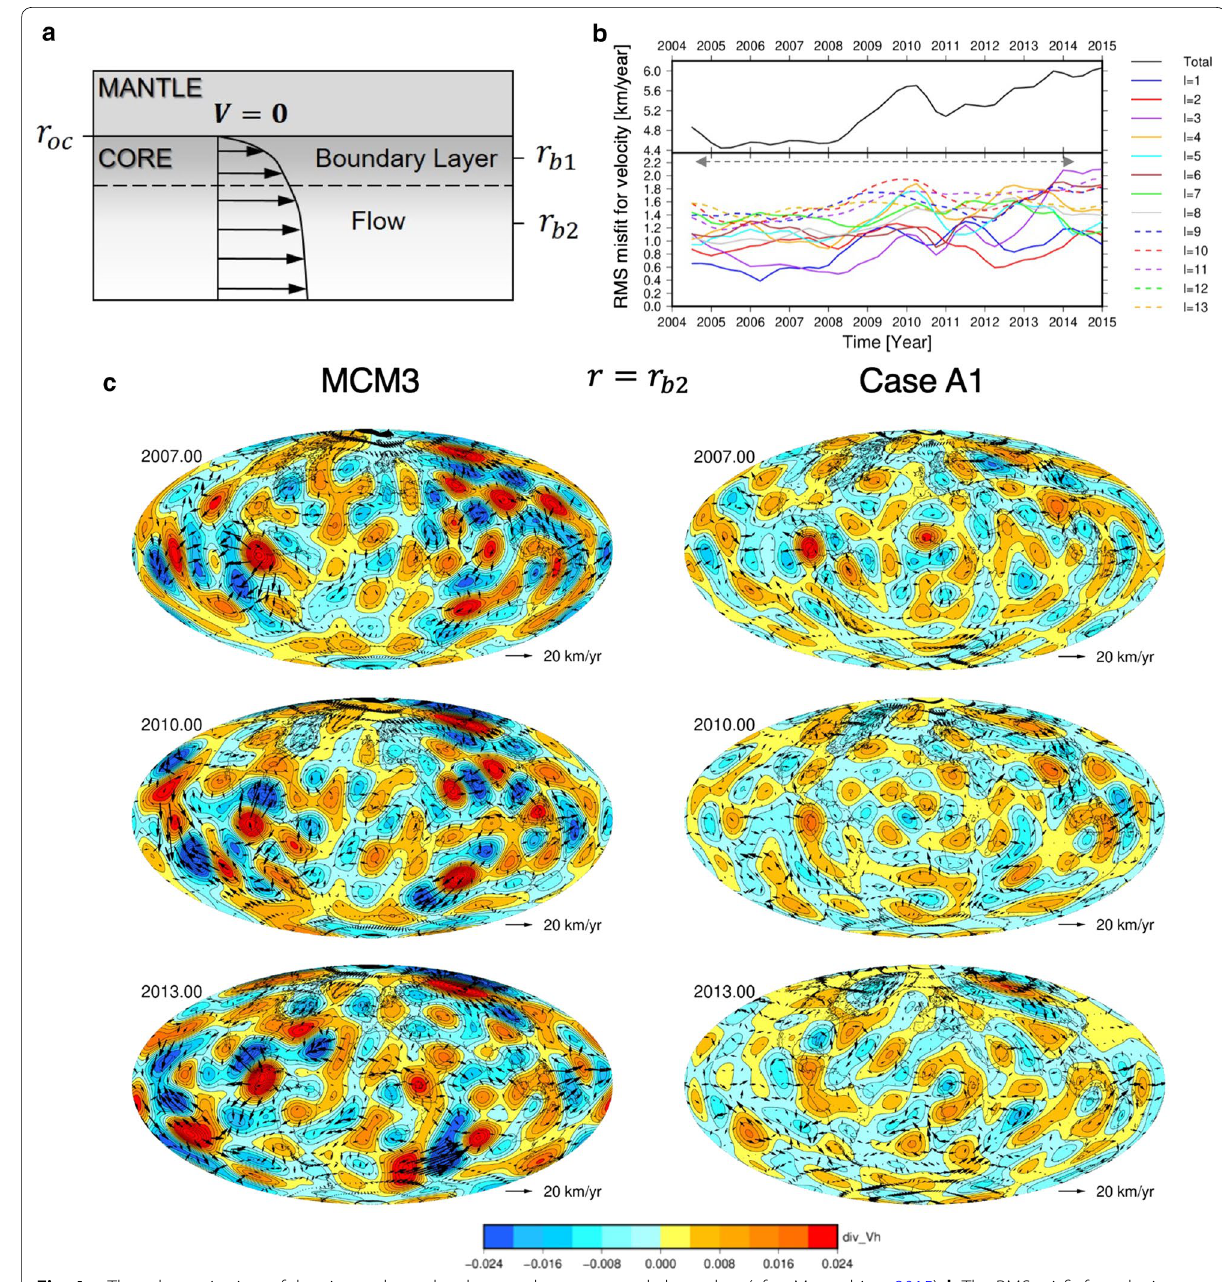
Fig. 4 a The schematic view of the viscous boundary layer at the core–mantle boundary (after Matsushima 2015), b The RMS misfit for velocity 3428.5 km (Eq. 42), where the gray horizontal dashed line denotes the assimilation window from 2004.50 to 2014.25, and c comparison at r b 2 = between the real core surface flows at r b 2 from the MCM3 model and the recovered velocity field for Case A1 (see Table 1 for details). Arrows denote the horizontal flow velocity field, while color contours show upwellings and downwellings given by horizontal divergence of the velocity field. The poloidal and toroidal scalar potentials of velocity are compared at r b 2 in our data